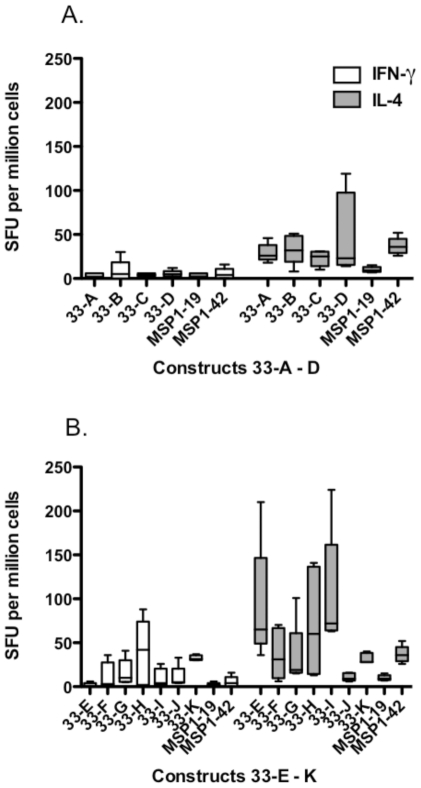
Induction of MSP1-specific IL-4 (grey bars) and IFN-γ (white bars) responses, as determined by ELISPOT, in mice immunized with truncated MSP1-42 proteins.Panel A: Constructs 33-A – 33-D; Panel B: Constructs 33-E – 33-K. Horizontal bars indicate mean SFU. Logistic Regression for Repeated Measures indicated that IFNγ levels were significantly higher (p<0.05) in Construct 33-E – 33-K compared to Construct 33-A – 33-D. No significant difference was found when comparing IL-4 levels. Mouse splenocytes were harvested 21 days after the last immunization.